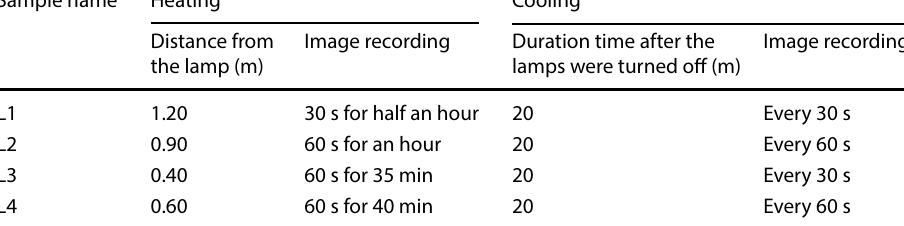
Fig. 3 Photo imaging of the thermographic investigation during the test analyses: a bet- ter explain the position of the two lamps (in the yellow circle) used to illuminate the sample (indicated by a blue arrow) and the operator with the thermo- graphic instrument used; b photo imaging of the analysis; c photo imaging of the imme- diate results on the infrared thermal imaging camera